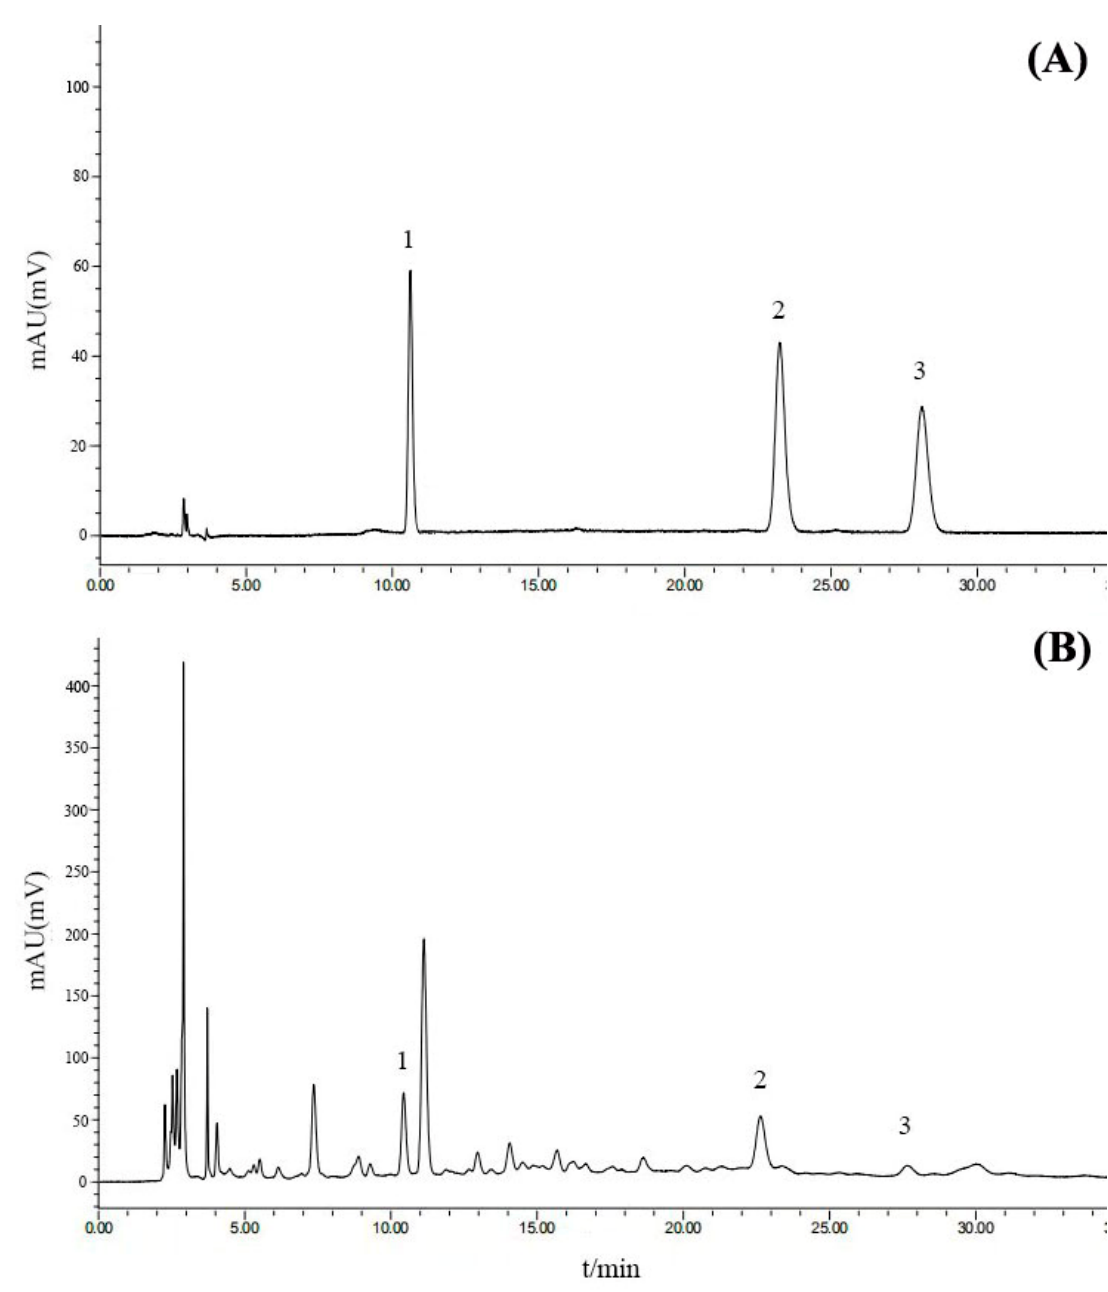
Figure 2. Chromatogram for peaks of eleutheroside B, eleutheroside E, and isofraxidin in Eleutherococcus senticosus . ( A ) Peaks of eleutheroside B (1), eleutheroside E (2), and isofraxidin (3) in the reference. ( B ) Peaks of eleutheroside B (1), eleutheroside E (2), and isofraxidin (3) in the tested samples.